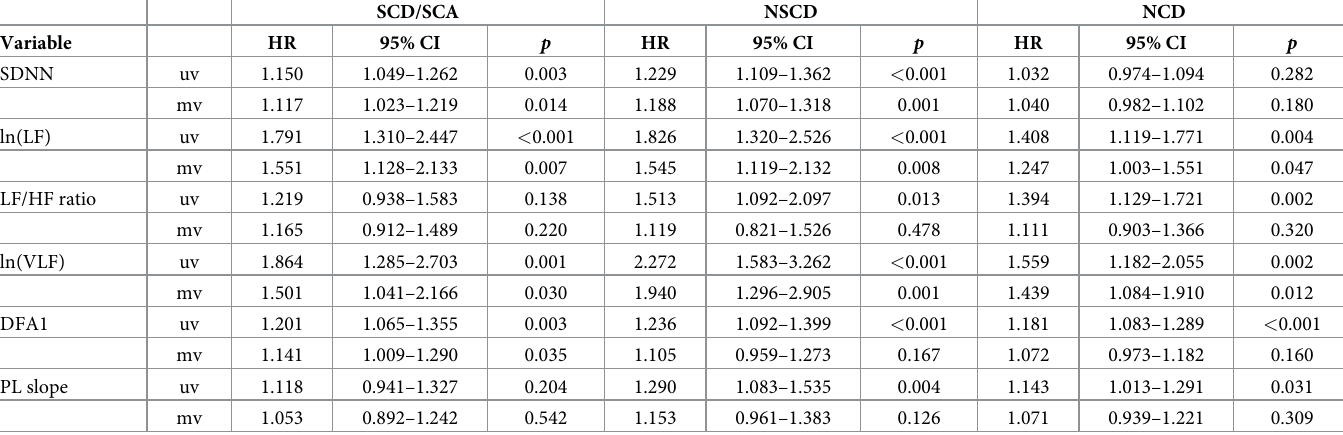
Table 5. Association of heart rate variability parameters with sudden cardiac death or sudden cardiac arrest, non-sudden cardiac death and non-cardiac death in the Cox regression analysis in the patients with